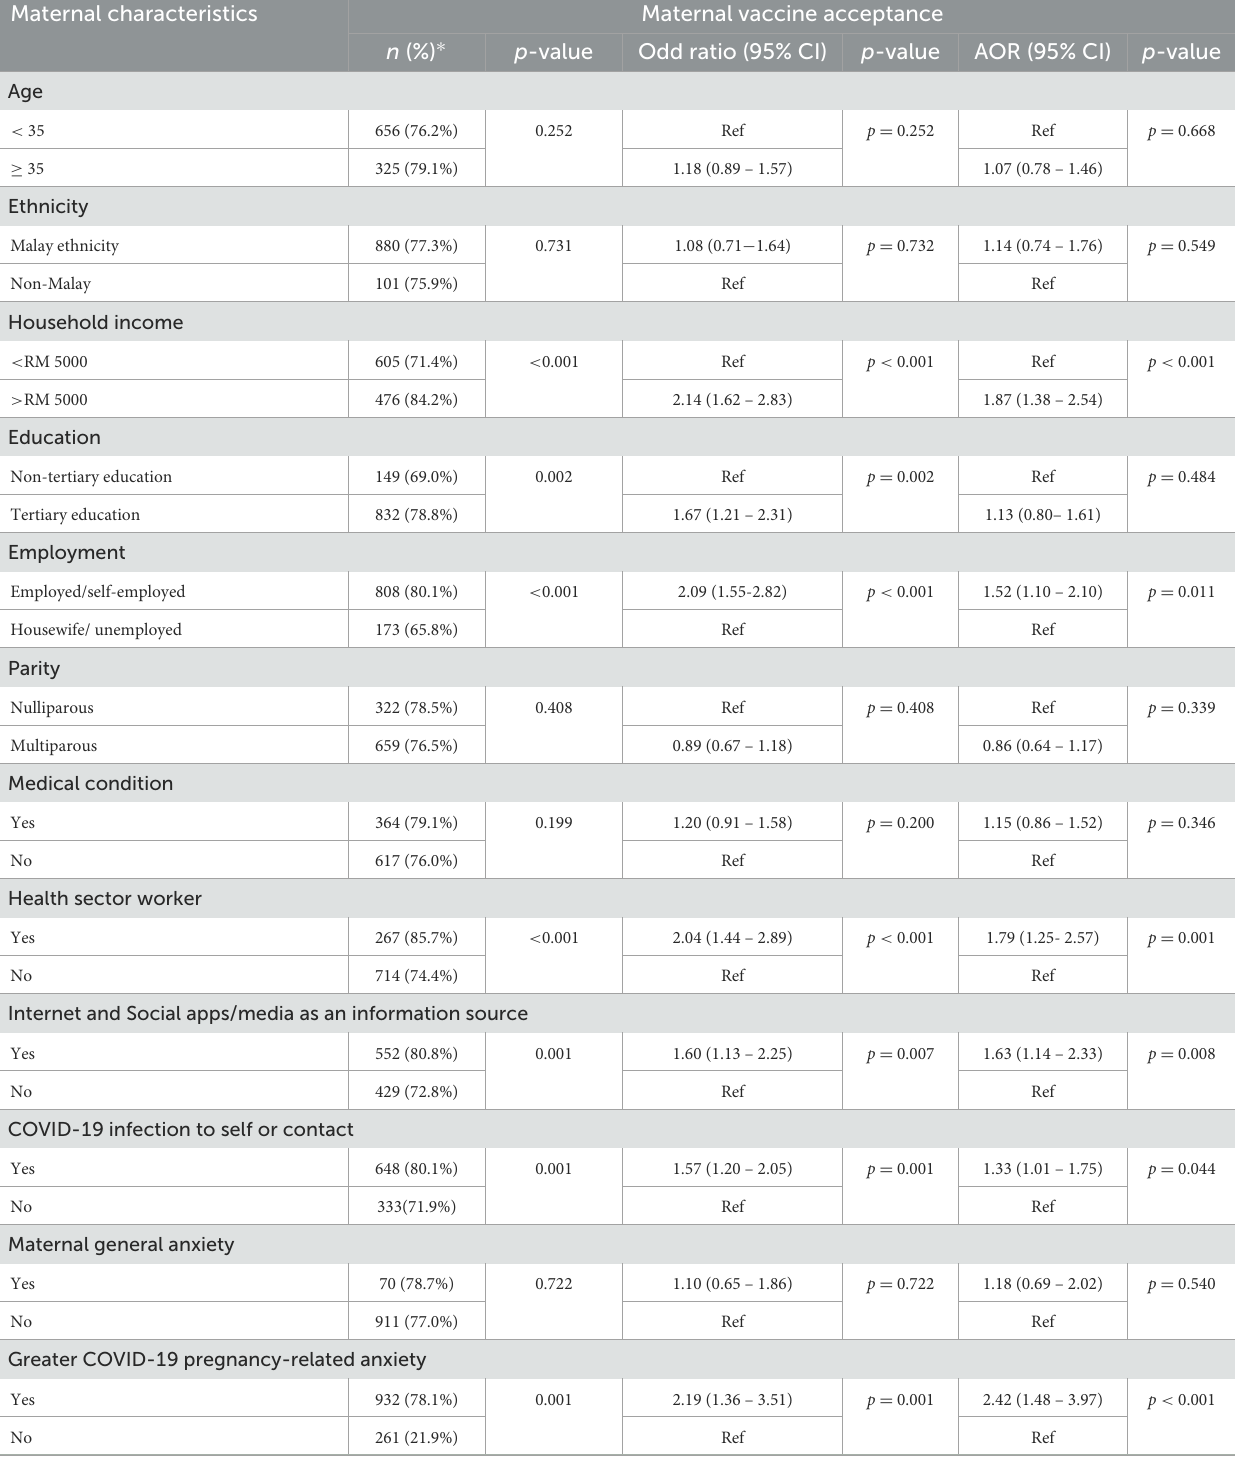
TABLE 4 Associations between maternal characteristics and COVID-19 vaccine acceptance. Maternal